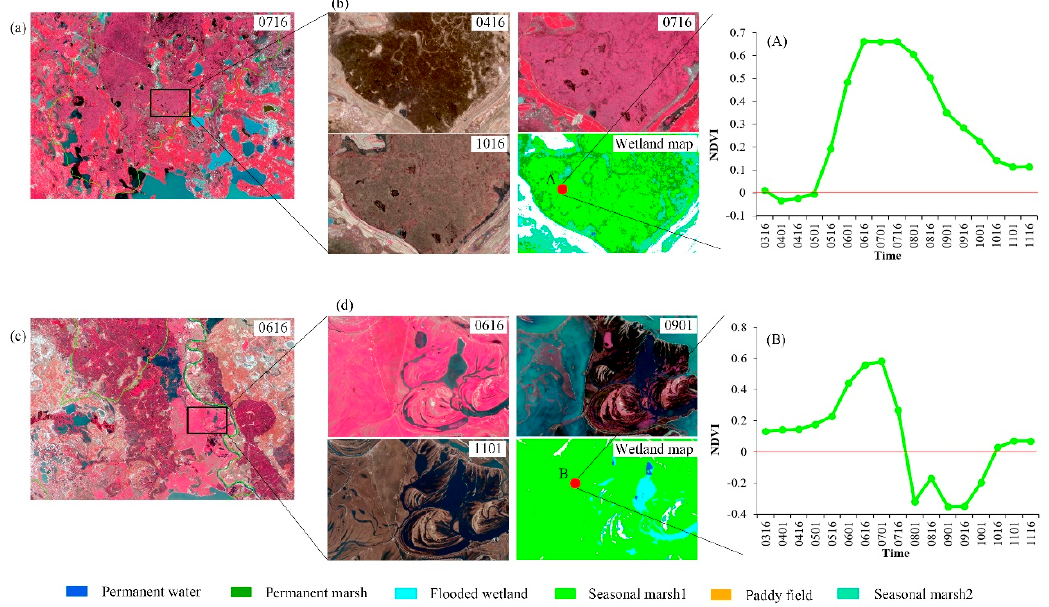
Figure 12. Seasonal marsh1 in different areas. ( a ) Location of the third subset in our study area (false colour image created from 15-day Sentinel-2 composited image between 16 and 31 July). ( b ) False colour image and our classification result for the third subset. ( A ) 15-day Sentinel-2 composited NDVI time series curves for the red point in Figure 12b. ( c ) Location of the fourth subset in our study area (false colour image created from 15-day Sentinel-2 composited image between 16 and 30 June). ( d ) False colour image and our classification result for the fourth subset. ( B ) 15-day Sentinel-2 composited NDVI time series curves for the red point in Figure 12d. Note: The times marked in the figure are the first dates of the 15-day Sentinel-2 composite